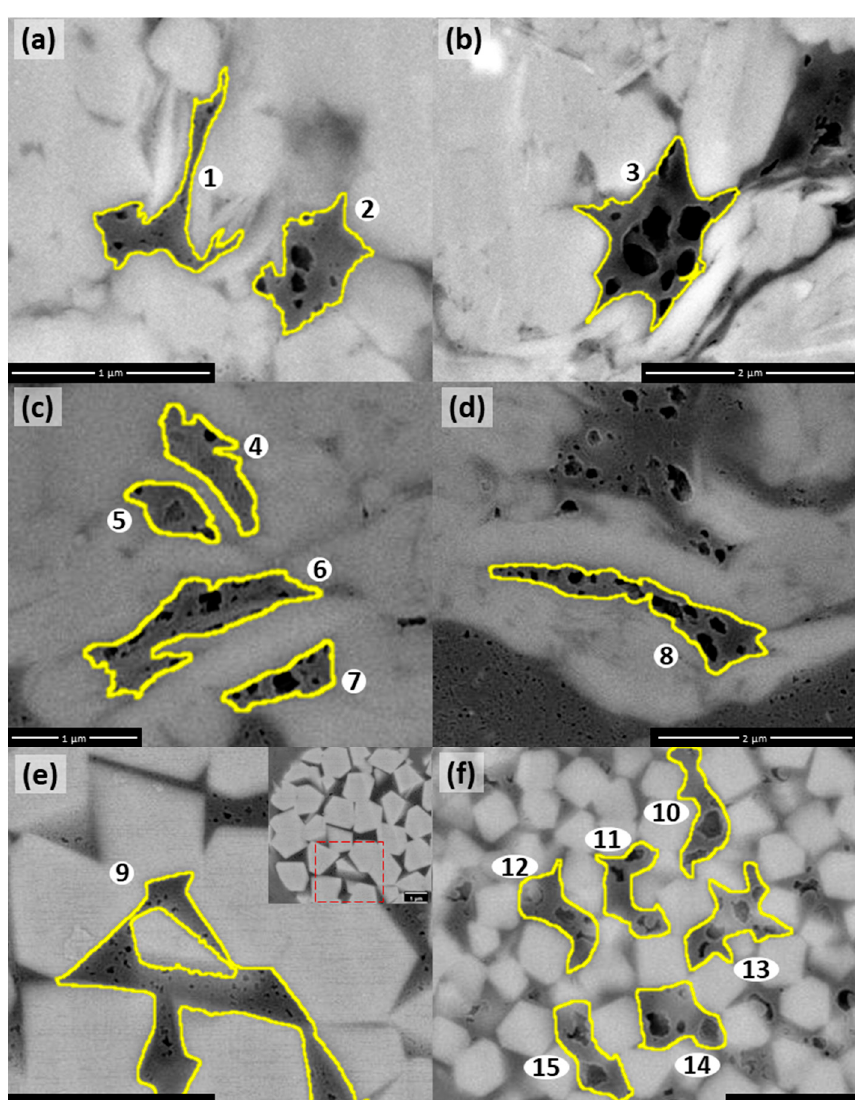
Figure 8. Typical examples of the third subtype of weakly or un-deformed porous pyrobitumen (OM III) and the statistical analysis of OM-hosted pores of Longmaxi-Wufeng Shale, Sichuan Basin. ( a ) SEM image JY1S-9-25 (well ID-sample no.-image no.); ( b ) SEM image JY1S-9-39; ( c ) SEM image JY1S-9-10; ( d ) SEM image JY1S-9-10; ( e ) SEM image JY1S-4-13; ( f ) SEM image JY1S-10-1. The yellow lines indicate the boundary of organic matter particles.